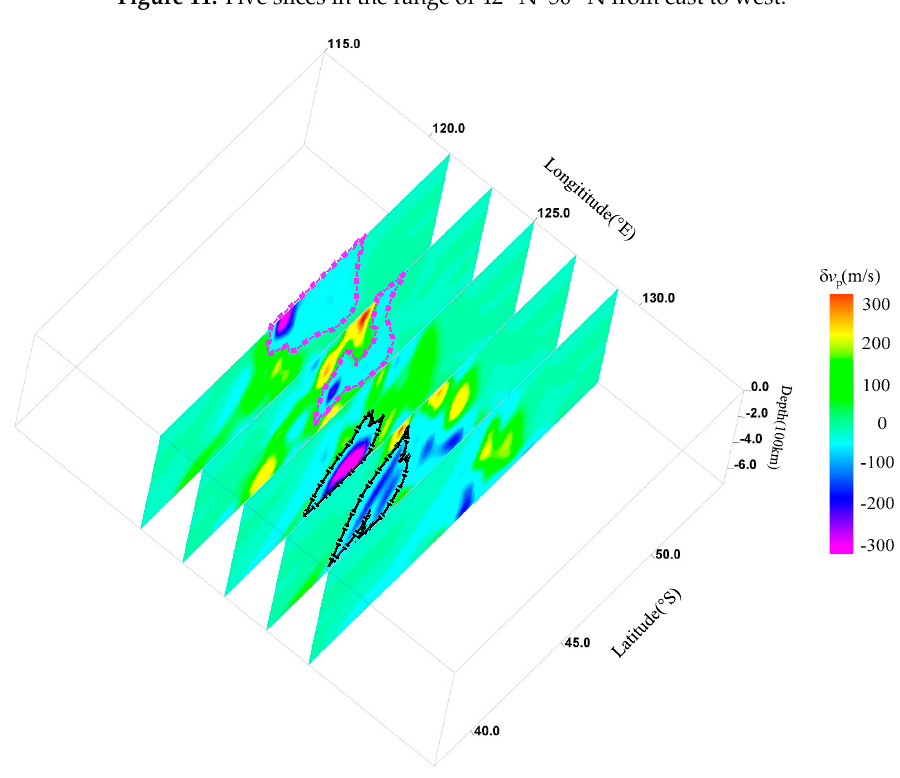
Figure 12. Five slices in the range of 122° E–130° E from north to south.